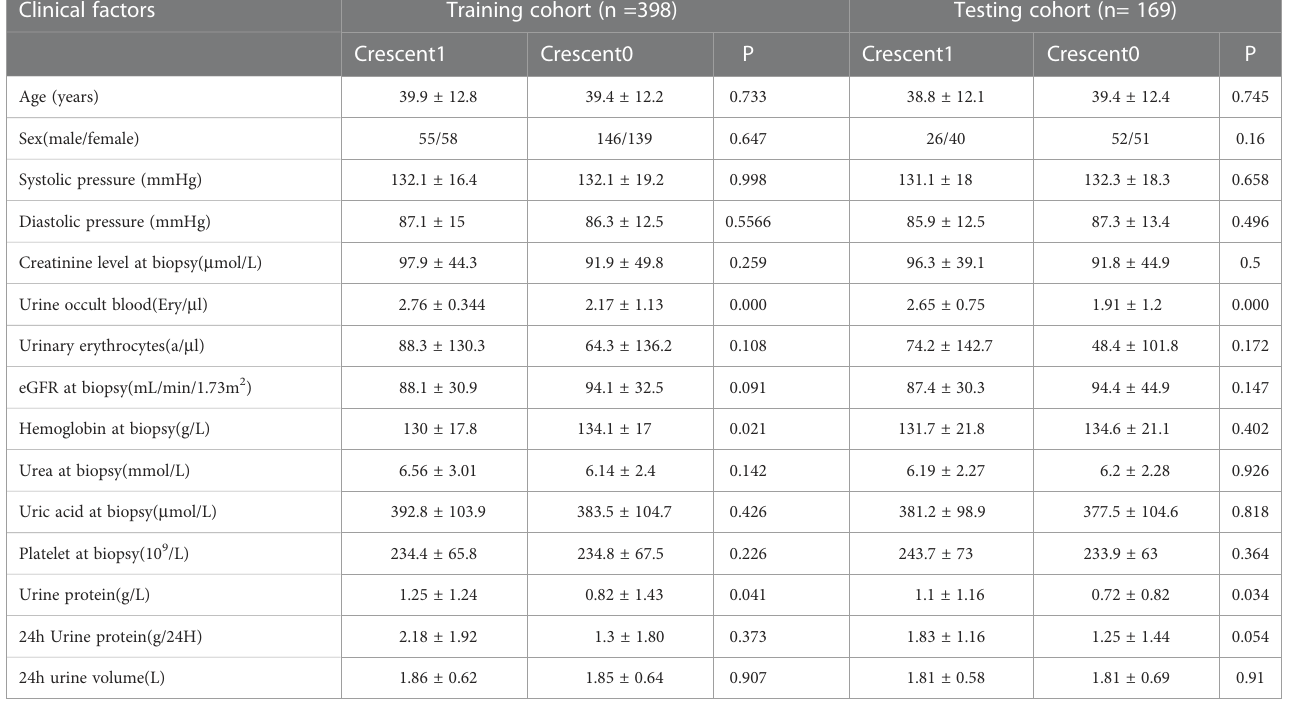
TABLE 1 Clinical factors in the training and testing